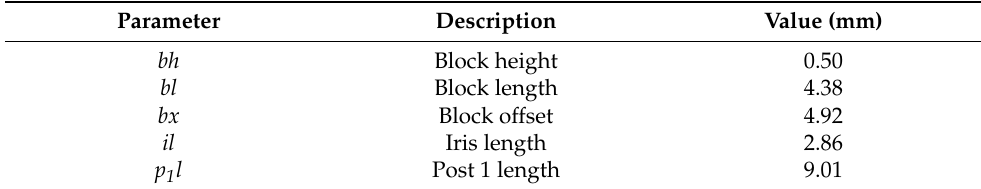
Figure 5. H-plane T-junction geometry. ( a ) Top view. ( b ) 3D view. Table 2. H-plane T-junction geometrical parameters.